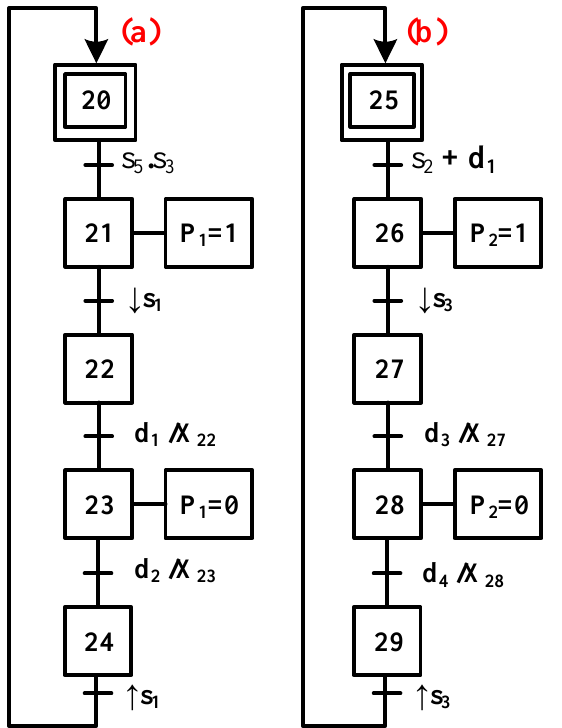
Figure 15. Degraded behavior grafcets of ( a ) P1, ( b ) P2.